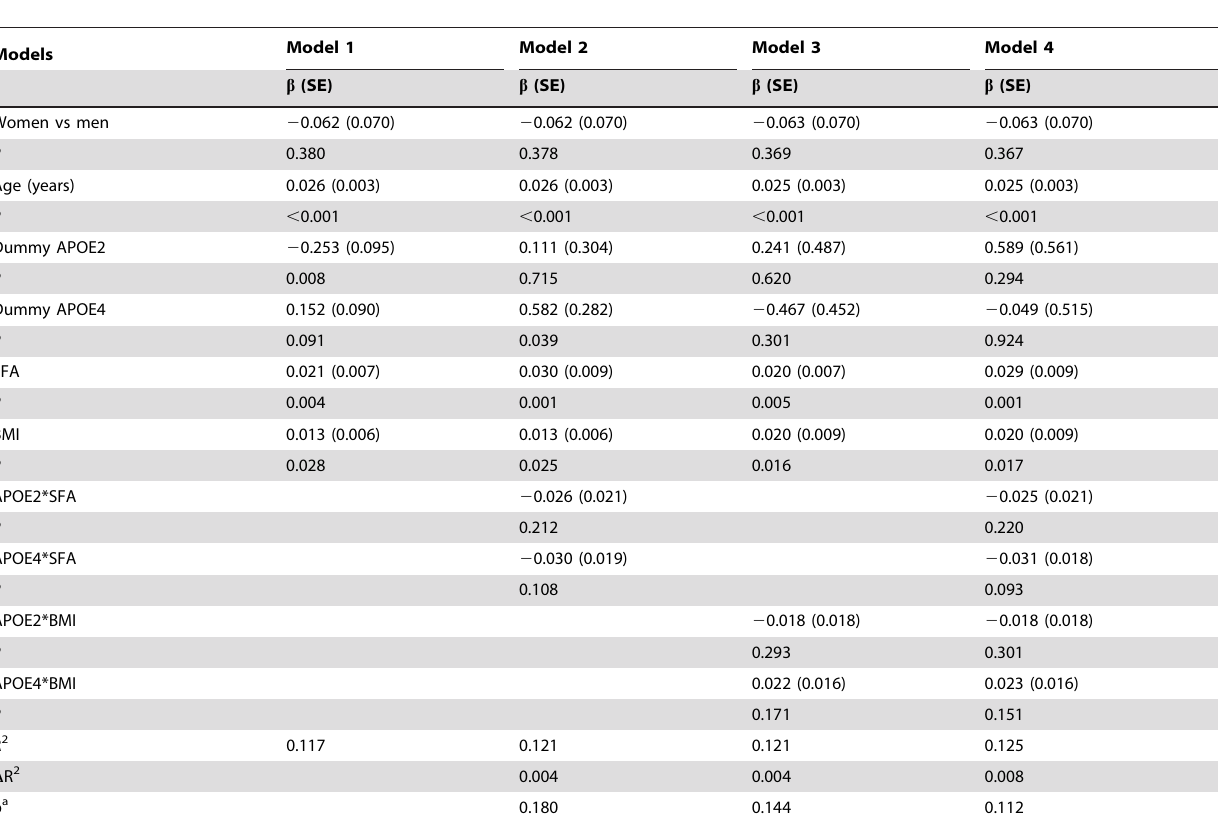
Table 5. Association of apolipoprotein E genotype, SFA intake, and BMI with total cholesterol.